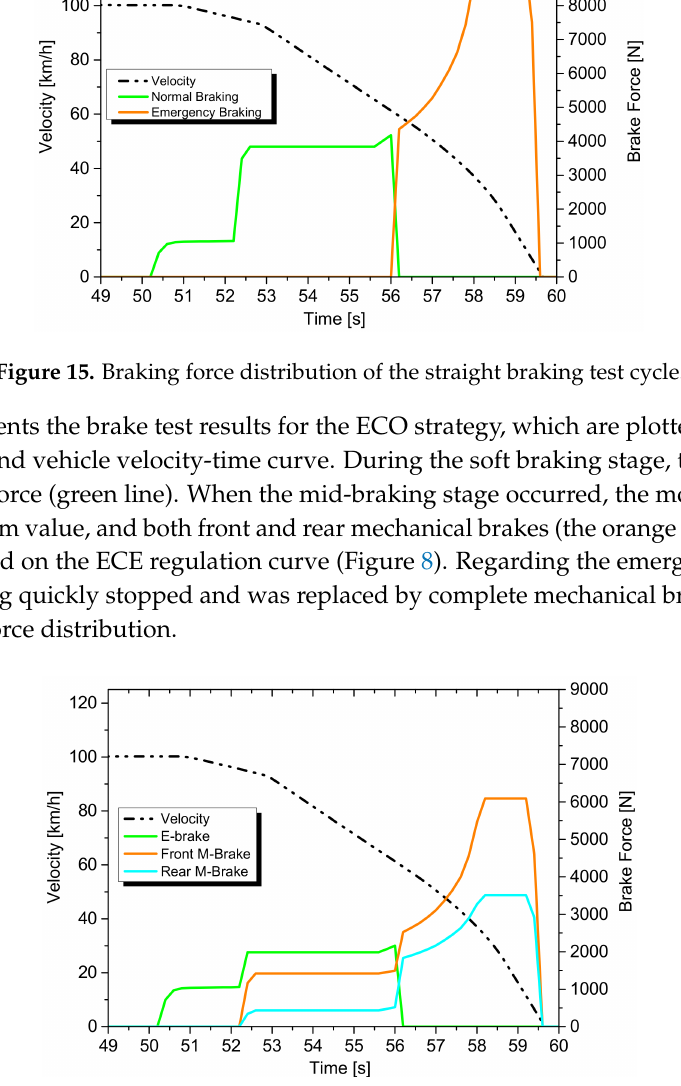
Figure 16. Braking force distribution in the ECO